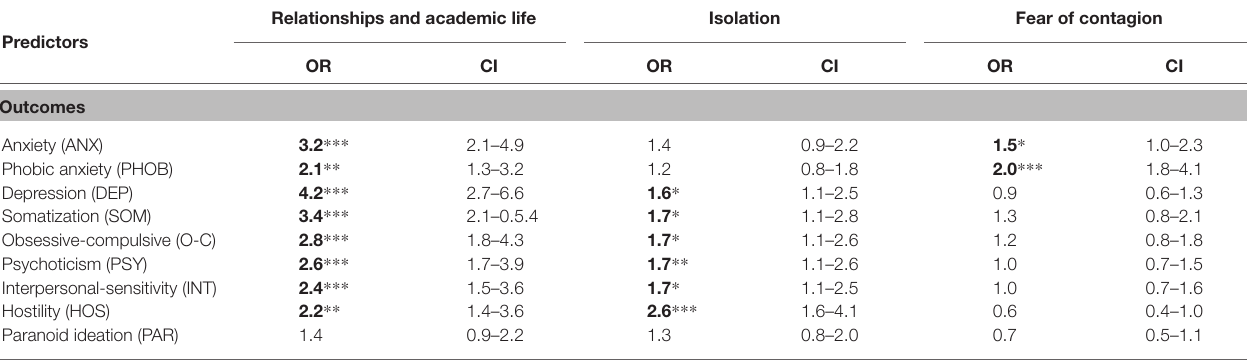
TABLE 4 | Logistic Regression Analyses: Associations between COVID-19-related stressors and psychological symptoms among university students ( n = 671). Relationships and academic life Isolation Fear of contagion Predictors